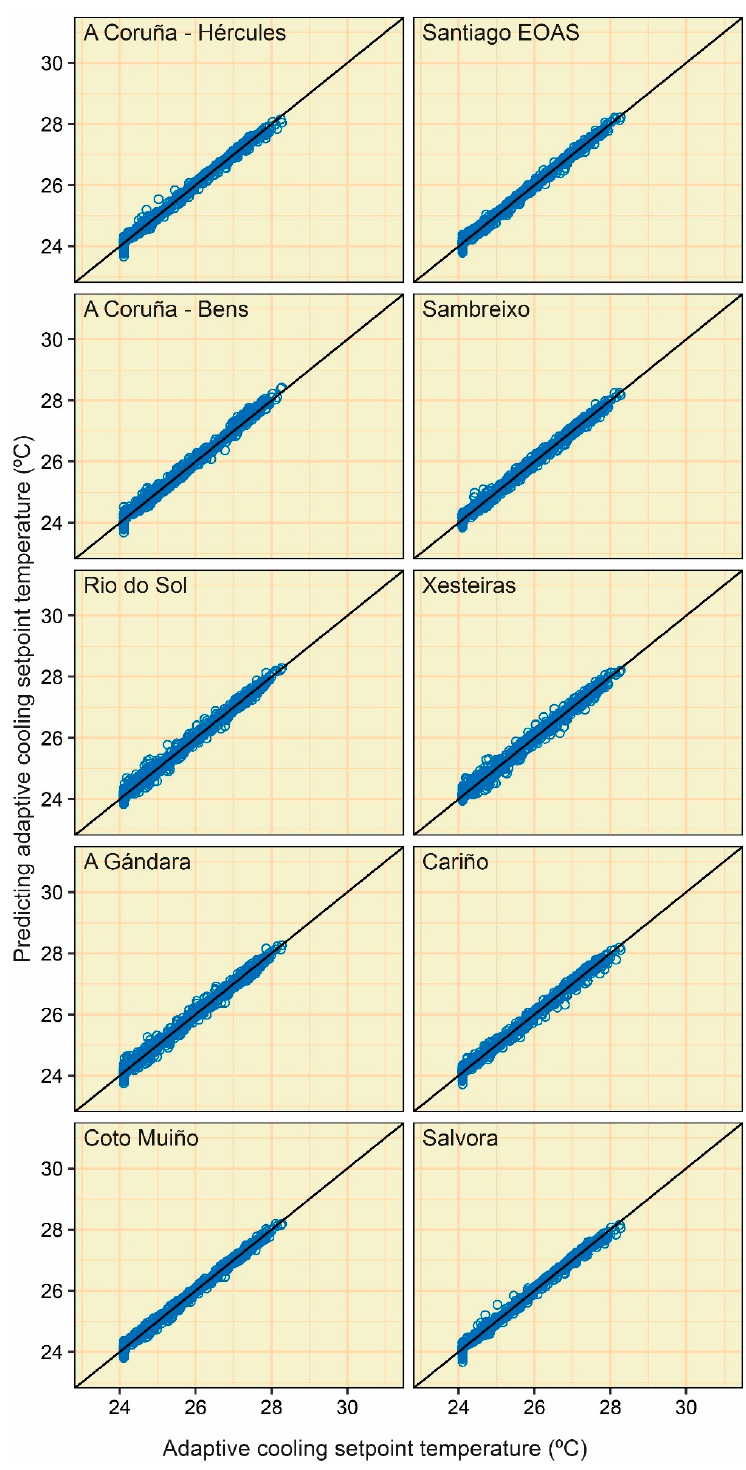
Figure A1. Point clouds between the actual and predicting adaptive cooling setpoint temperature values (category I) of the MLR (approach 1).